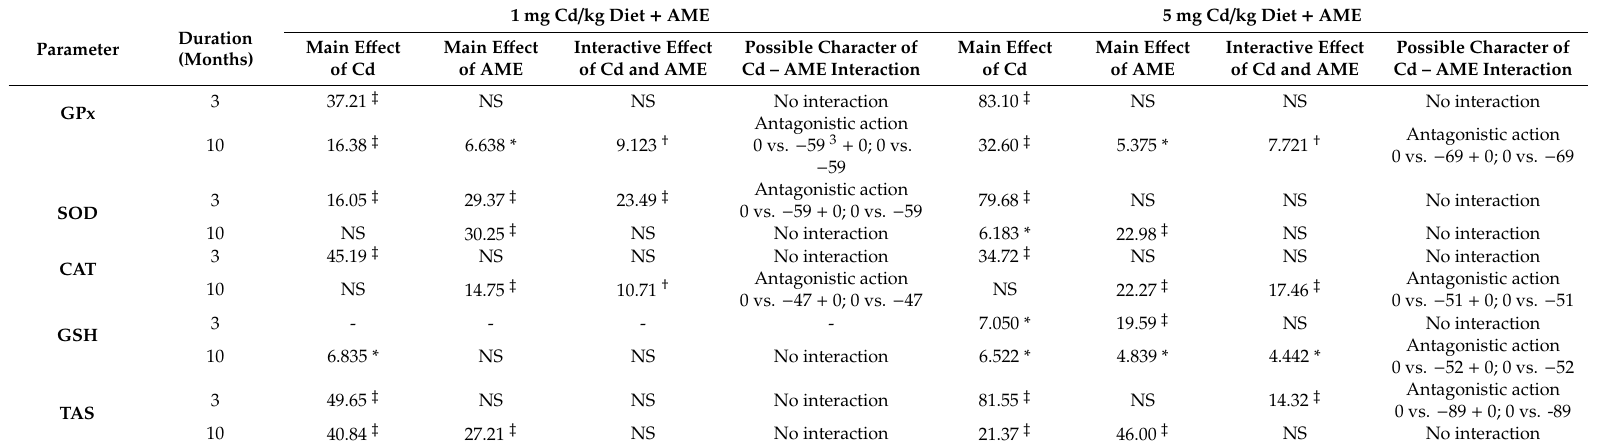
1 The results of the two-way analysis of variance are presented as F values and the level of statistical significance ( p ). F values having p < 0.05 were recognized statistically significant (* p < 0.05, † p < 0.01, ‡ p < 0.001). NS – not statistically significant. 2 To estimate the possible character of the interaction between Cd and AME, the e ff ect noted at their co-administration was compared to the sum of the e ff ects after their separate administration (Cd + AME e ff ect vs. Cd e ff ect + AME e ff ect). Cd e ff ect, AE e ff ect, and Cd + AME e ff ect are expressed as percentage changes (-, decrease) of a measured parameter in comparison to the respective control group. 3 The values represent percentage changes. GPx, glutathione peroxidase;